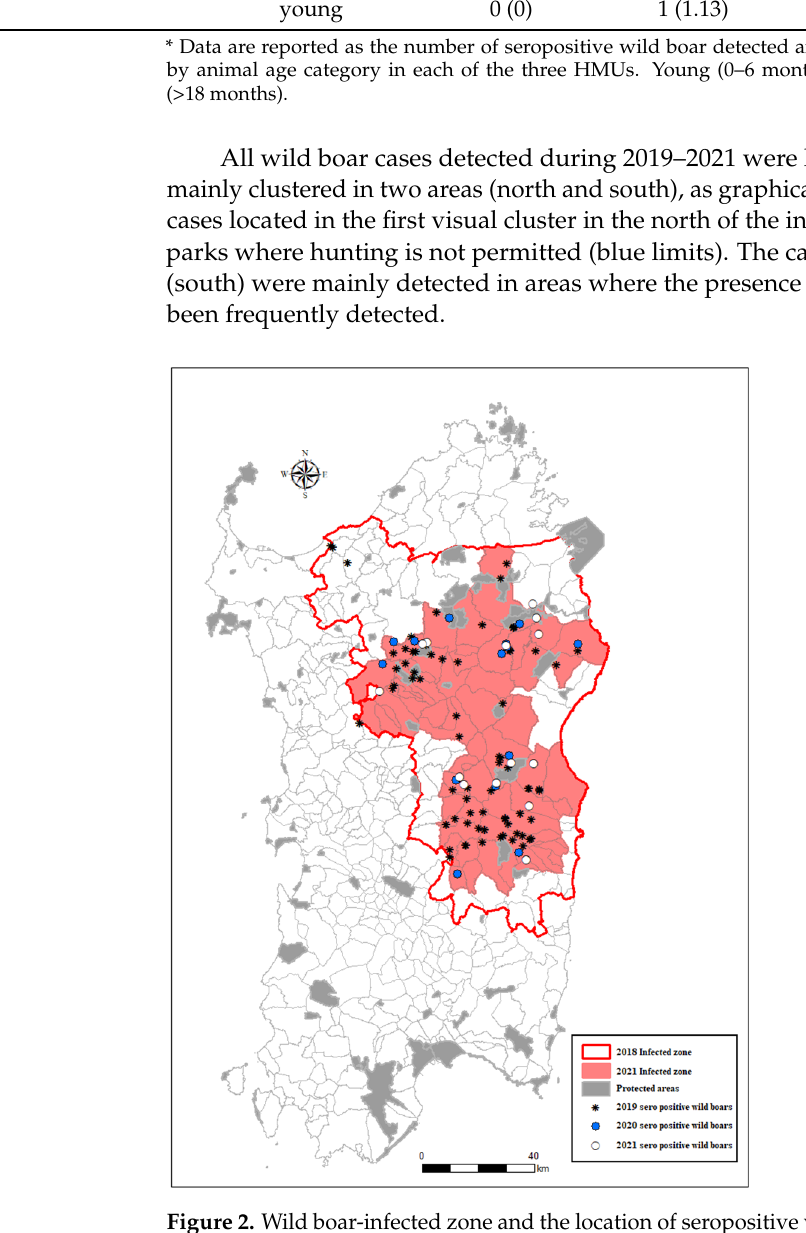
Figure 2. Wild boar-infected zone and the location of seropositive wild boars in Sardinia in 2019–2022. As previously described, until 2020, the surveillance of wild boar shows the temporal clustering of the sampling, with most samples taken during the hunting season